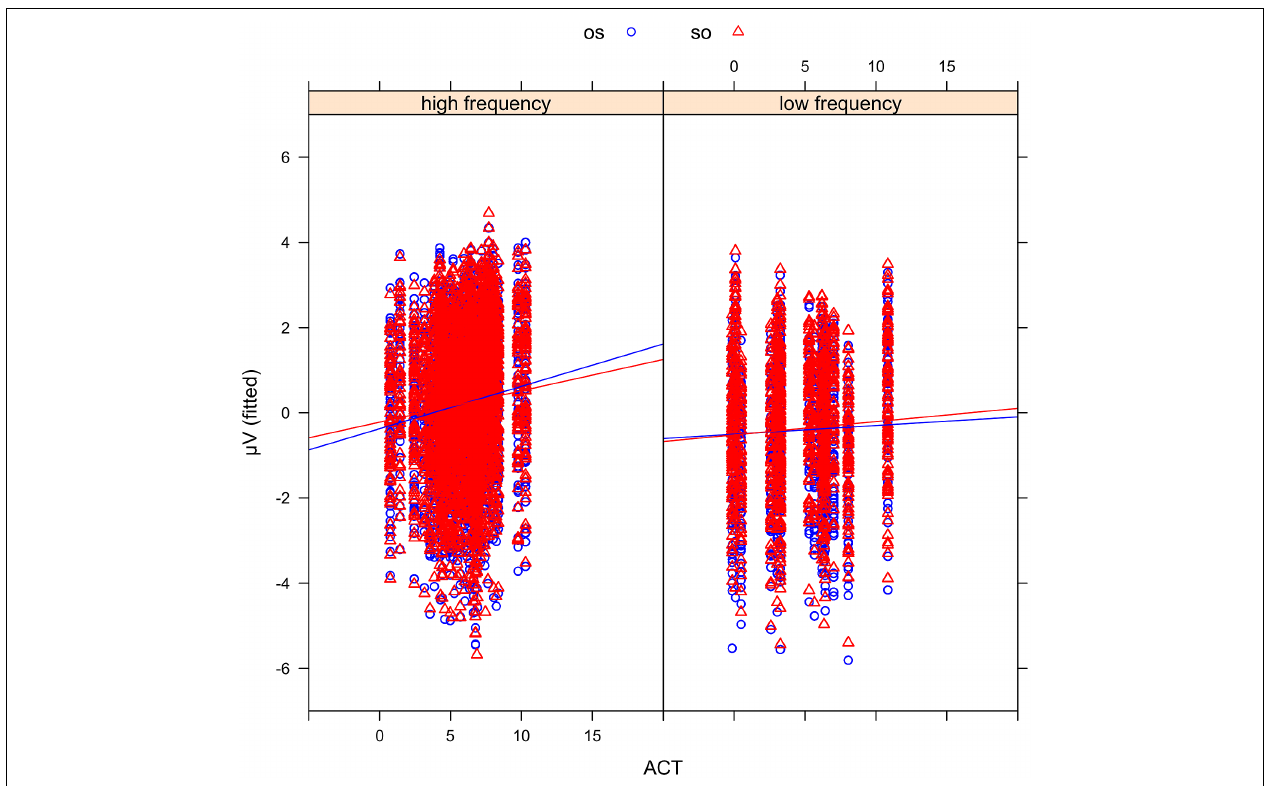
FIGURE 10 | Mean voltages plotted against actorhood potential (ACT) for high (left panel) and low frequency (right panel) human nouns only. Sentences in object initial order (OS) are shown in blue circles and sentences in subject initial order (SO) in red